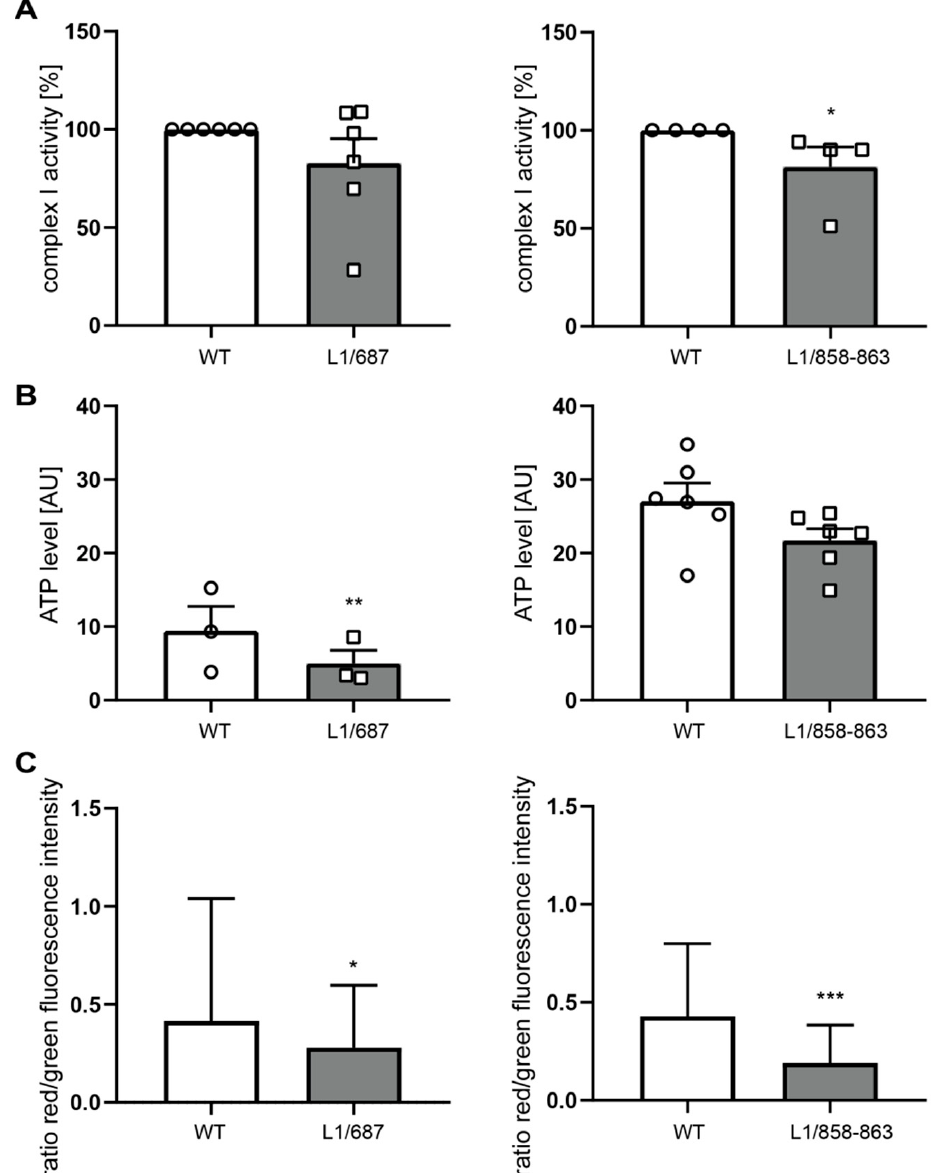
Figure 4. Mitochondria from L1/687 and L1/858-863 mice show a reduced membrane potential. ( A ) Mitochondrial Complex I activity was determined using isolated mitochondria from whole brains of 7- to 9-day-old male L1/687, L1/858-863 (gray bars) and wild-type (WT, white bars) littermate mice. ( B , C ) Mitochondrial ATP levels ( B ) and mitochondrial membrane potential ( C ) were determined in cultured cerebellar neurons from 7-day-old male L1/687, L1/858-863 (gray bars) and wild-type littermate (WT, white bars) mice. Means ± SD ( C ) or means ± SEM and values from individual mice ( A , B ) are shown; L1/687: n = 6 for Complex I activity, n = 3 for ATP level and membrane potential; L1/858-863: n = 4 for Complex I activity, n = 6 for ATP levels and n = 3 for membrane potential. * p < 0.05, ** p < 0.01, *** p < 0.005 (Mann–Whitney test).